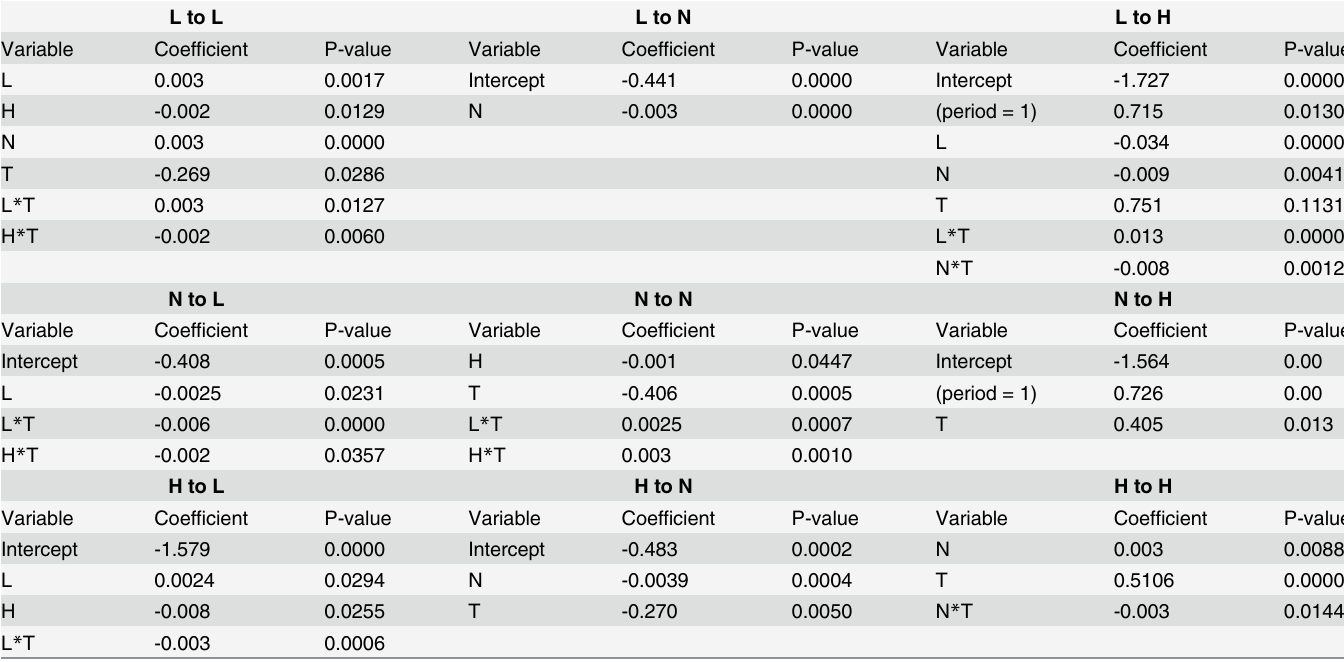
Table 3. Results of Conscientiousness State. The mere effects of social-situational factors (intensity with alters in each level: L, N and H) and correspond- ing traits of egos (T) are reported in the table, if they are statistically significant. The interaction results between the two effect are reported also ( L (cid:1) T , N (cid:1) T and H (cid:1) T ), if they are statistically significant. The coefficients of the control variables are reported also: the main effect of the time of the day (period) and the interaction between the time of the day and the trait (period * T). Some reported coefficients are relatively small, therefore we used a threshold of 0.001 to con- sider them relevant. We focus more on the direction of the effect (increase or decrease in the probability) rather than the actual value of the